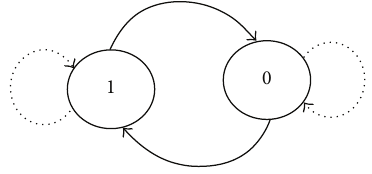
Figure 3: Two-state Markov chain transmission channel